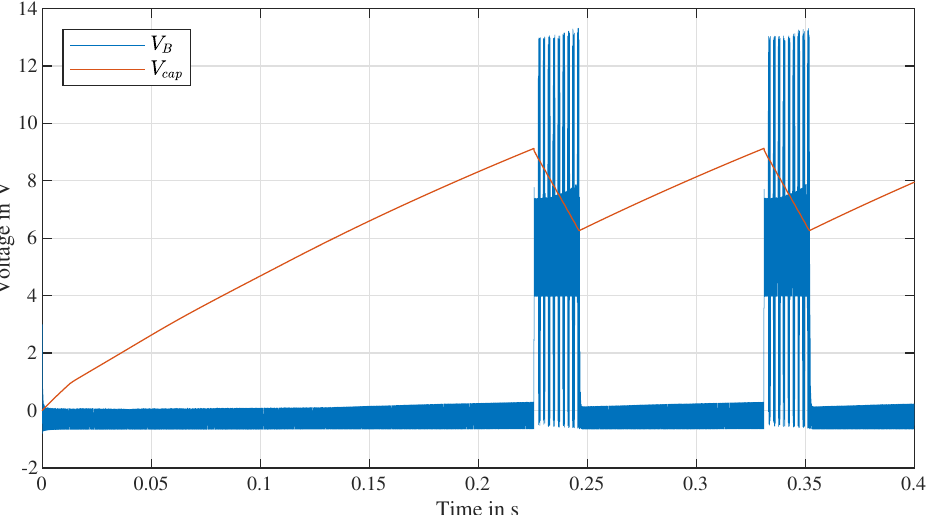
Figure 10. Simulated voltages across the capacitor C s ( V cap ) and at node B ( V B ) from the transmitter circuit in Figure